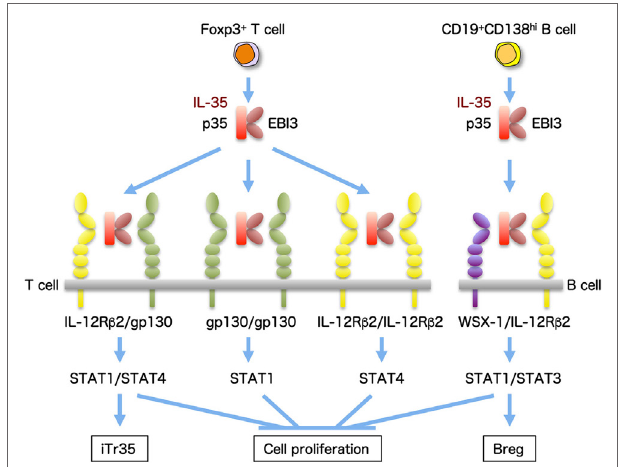
FiguRe 3 | iL-35 and the composition of its receptor subunits . IL-35, a heterodimeric cytokine of p35 and EBI3, is preferentially secreted by forkhead box P3 (Foxp3 + ) Treg cells and induces IL-35-producing Treg (iTR35) cells with immunosuppressive activity. The receptor for IL-35 is a heterodimer of gp130 and IL-12R β 2, and it signals via activation of a heterodimer of STAT1 and STAT4. In addition, IL-35 also has the ability to mediate signaling in the presence of only one of them as a homodimer. IL-35 also produced from CD19 + CD138 hi B cells induces the expansion of B regulatory (Breg) cells producing IL-35 and, intriguingly, activates a heterodimer of STAT1 and STAT3 through the IL-35 receptor comprising IL-12R β 2 and WSX-1.